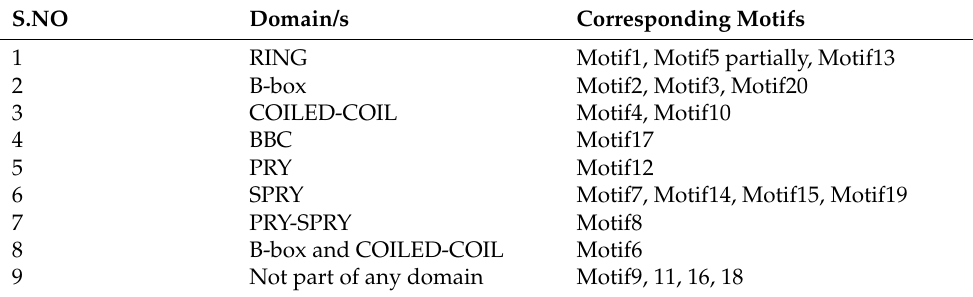
Table 1. Shows the domains that correspond to identified motifs.